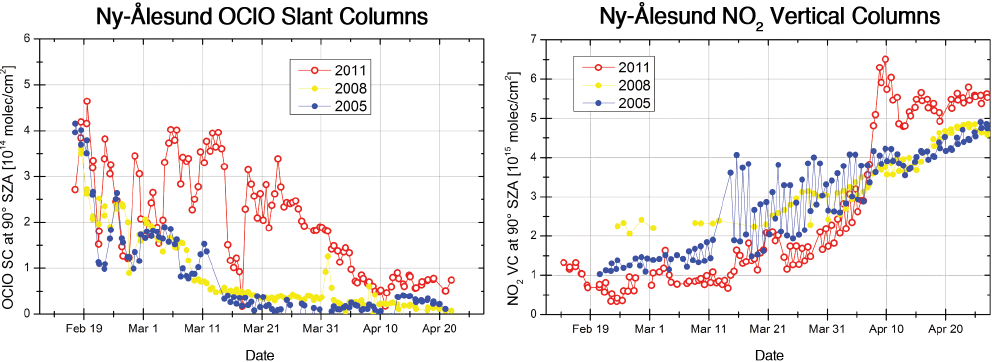
Fig. 12. Ground-based measurements of (a) OClO slant columns and (b) vertical columns of NO 2 in Ny-Ålesund (78.55 ◦ N, 11.55 ◦ E) at 90 ◦ SZA for winter–spring period of 2005, 2008, and